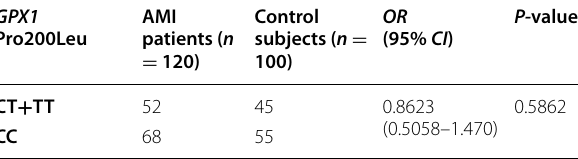
Table 2 Odds ratio (OR) with 95% confidence intervals (CI) for GPX1 Pro200Leu in study groups GPX1 AMI Pro200Leu patients ( n